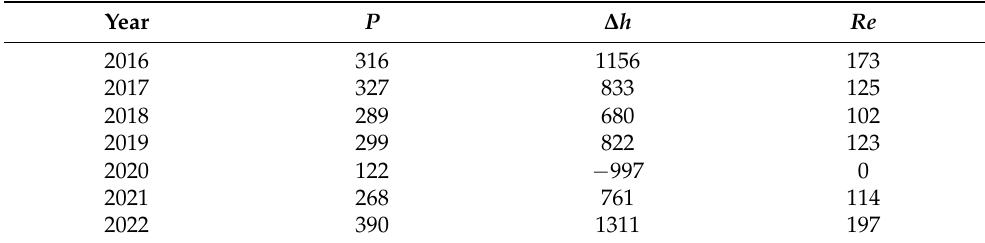
Table 3. Yearly precipitation ( P ), seasonal changes in groundwater level ( ∆ h ), and aquifer recharge ( Re ) for years 2016 to 2022. All data are in